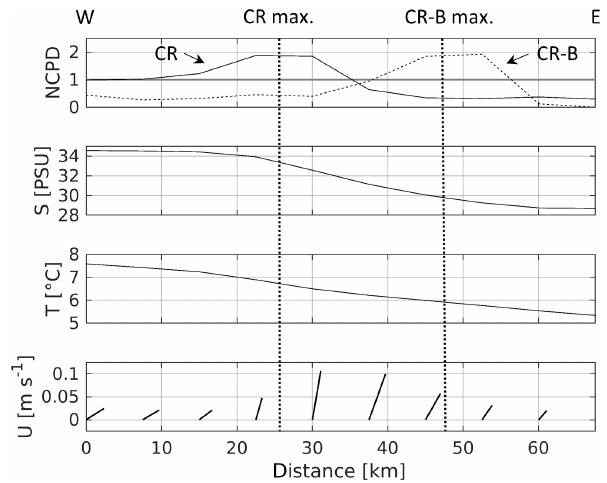
Figure 7. Normalised cumulative particle density (NCPD), salinity ( S ), temperature ( T ) and residual velocity vectors ( U ) at the surface as the means of January 2015 along the transect in the Southern Bight (solid black line in Fig. 5a) in the control run (CR). The graph starts in the west and ends at the coast. The vertical dotted lines mark the NCPD maxima of the forward (left one, solid NCPD line) and backward (right one, dashed NCPD line) simulations (CR and CR-B, nos. 1 and 5, respectively; see Table